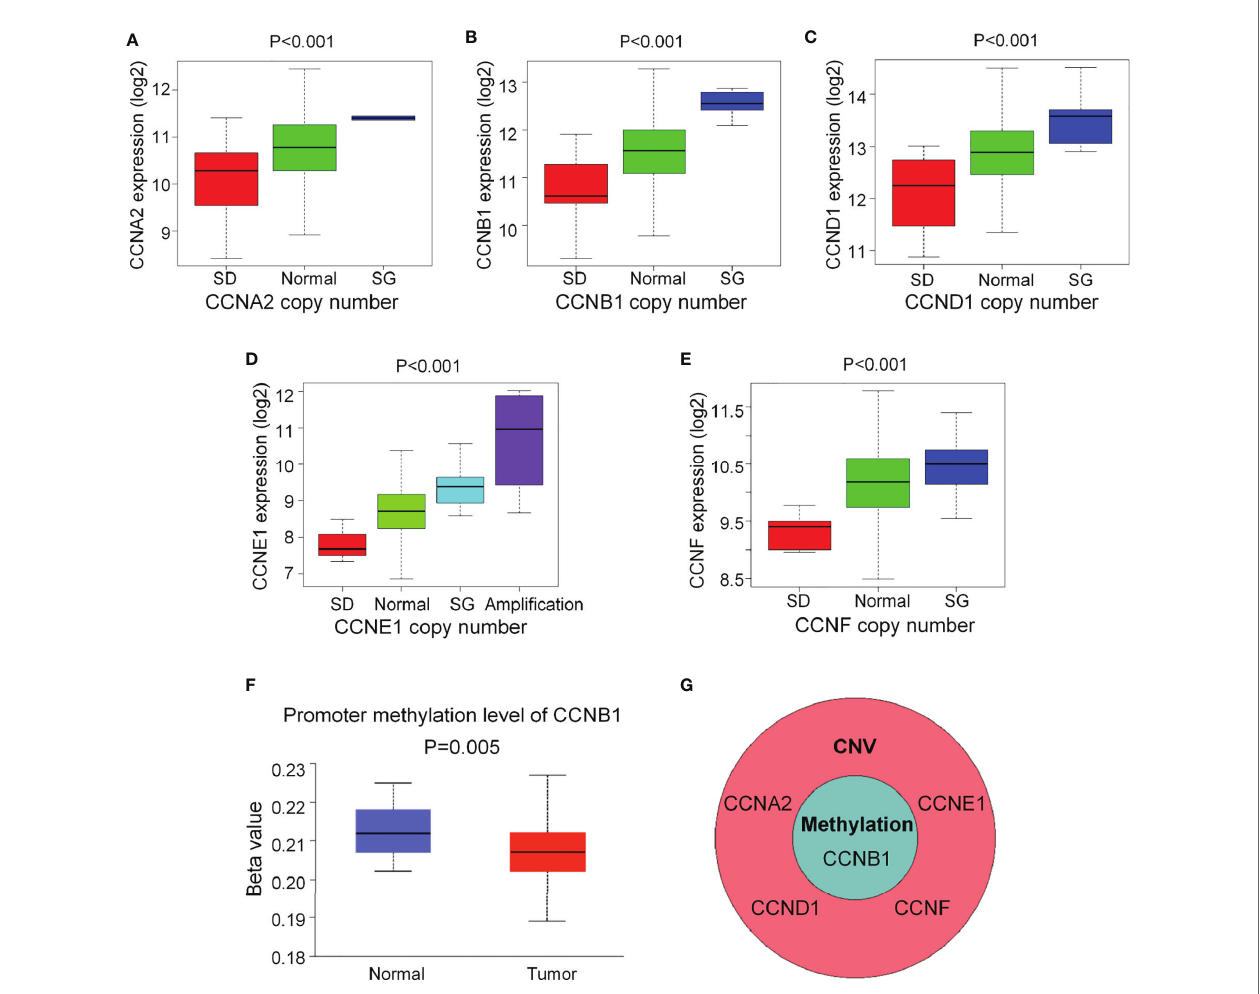
FIGURE 3 | The CNV and DNA methylation of the six cyclin DEGs in patients with COAD from TCGA. (A – E) The copy number of CCNA2 , CCNB1 , CCND1 , CCNE1 , and CCNF was positively associated with gene expression. For CCNJL , see Supplementary Figure 1A . SD, single deletion; SG, single gain. (F) The methylation levels of CCNB1 were noticeably lower in tumor tissues. For the other fi ve genes, see Supplementary Figures 1B-F . (G) CCNB1 was the only gene showing signi fi cant difference in terms of CNV and methylation. CNV, copy number